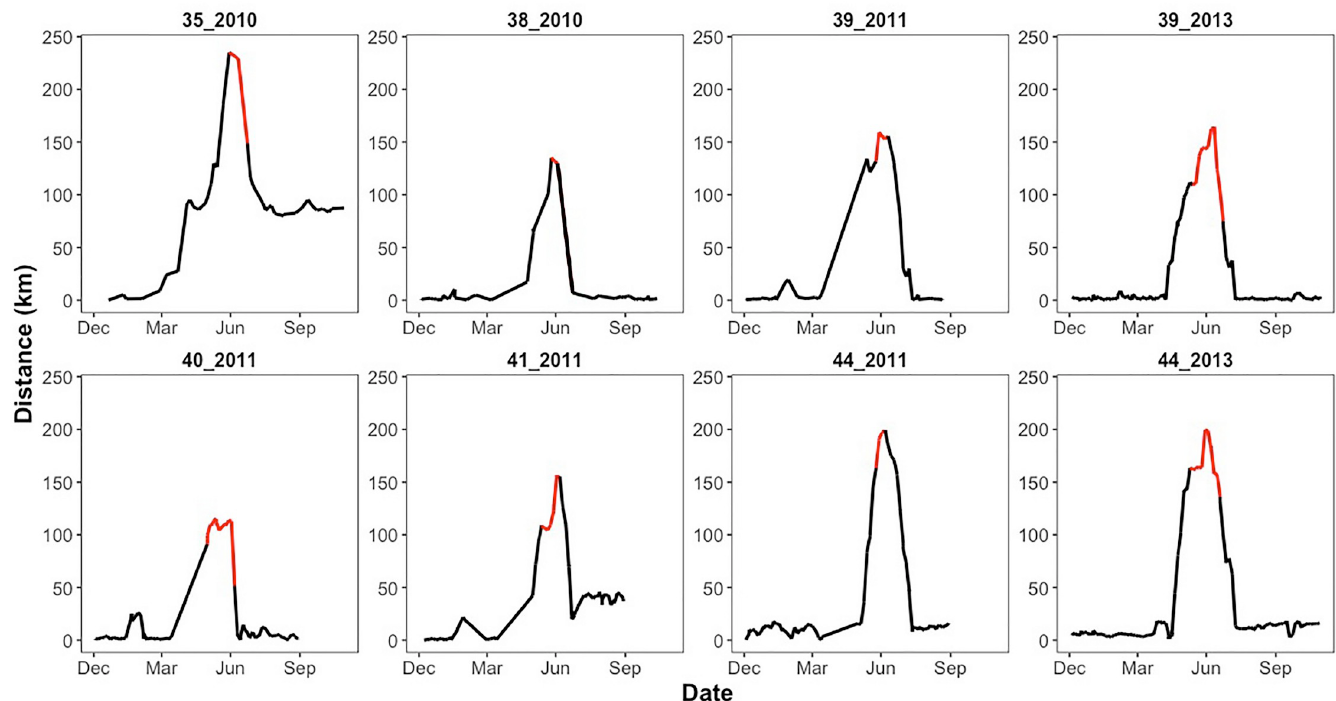
Fig 2. Net-square displacement (NSD) plot for each migration cycle of each individual Tibetan antelope ( Pantholops hodgsonii ) (individual ID_year). The NSD plot represents the distance to the starting point (wintering sites) where Antelopes stay at the beginning of a calendar year. During winter (the beginning of the graphs) the distance remain low until they depart for their calving site in late spring. They arrive at calving site in June when they reach the largest distance from the wintering site. Calving periods are represented by the peak of the graphs (highlighted in red), after which antelopes initiate the returning migration and distance starts to decrease. All antelopes except for 35_2010 and 41_2011 returned to their original wintering sites and the distances drop back to around 0.